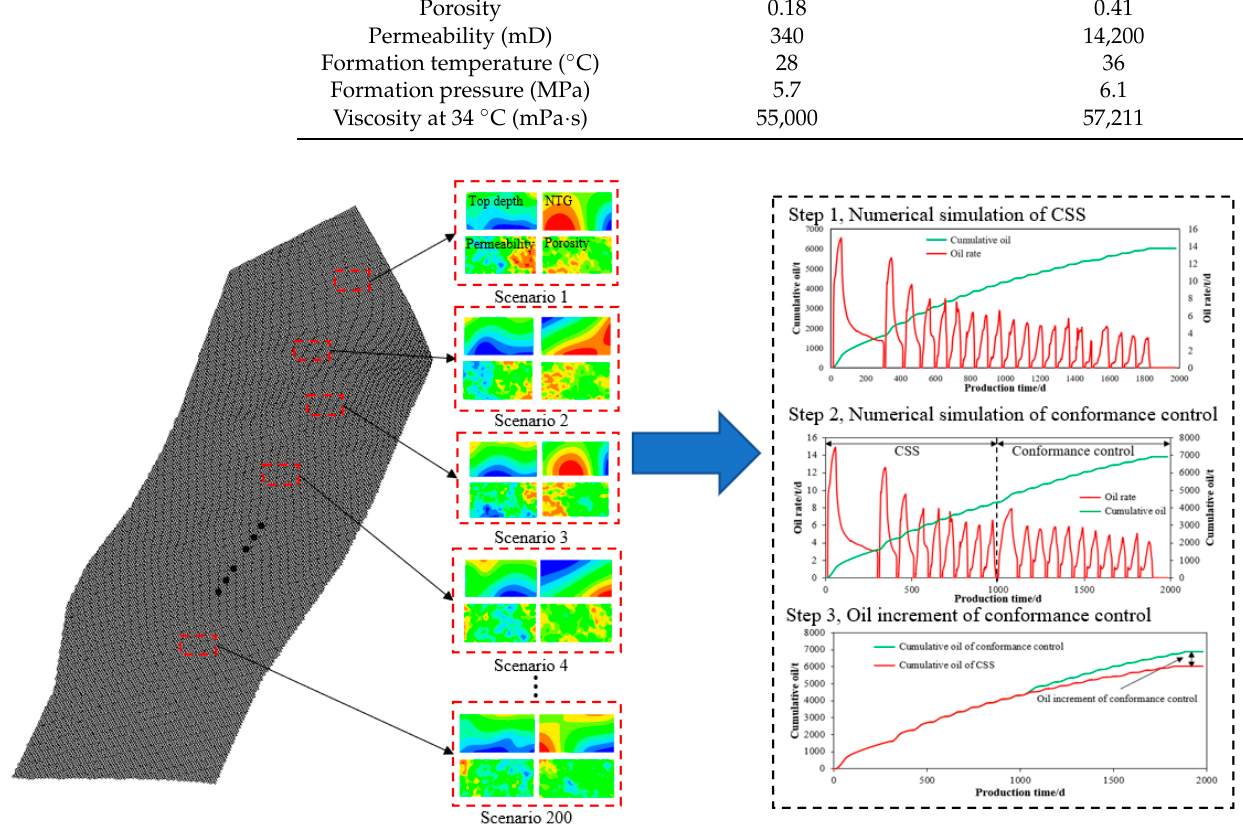
Figure 1. Workflow for predicting the performance of conformance control by numerical simulation, including extracted model, and calculating the oil increment of conformance control.